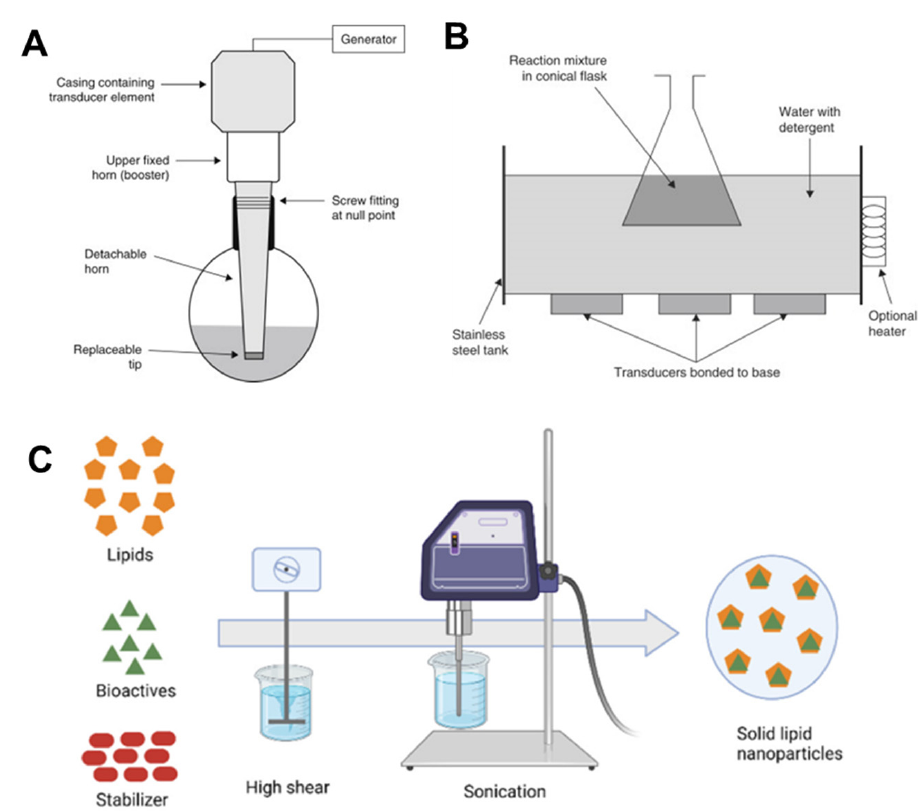
Figure 3. Schematic representation of the sonication method for the SLN probe sonicator ( A ), bath sonicator used in academic labs ( B ) and SLN preparation by the sonication method ( C ). In this technique, the lipids will be melted and the aqueous phase with surfactants is then sonicated using probe sonicator to form emulsions with reduced droplet size. Gradual cooling of the emulsion below the crystallization temperature helps in formation of the SLN dispersions. Note: ( A , B ) figures are adapted with permission from Ref. [23]. Copyright 2014, Elsevier, and ( C ) is adapted from Ref. [24]. The probe ultrasonication technique was used by Bose et al. to produce quercetin SLN [25]. V. Venkateswarlu and K. Manjunath developed clozapine-loaded SLNs using point of lipids, and the results indicated that more than 90% of the drug was entrapped in SLN